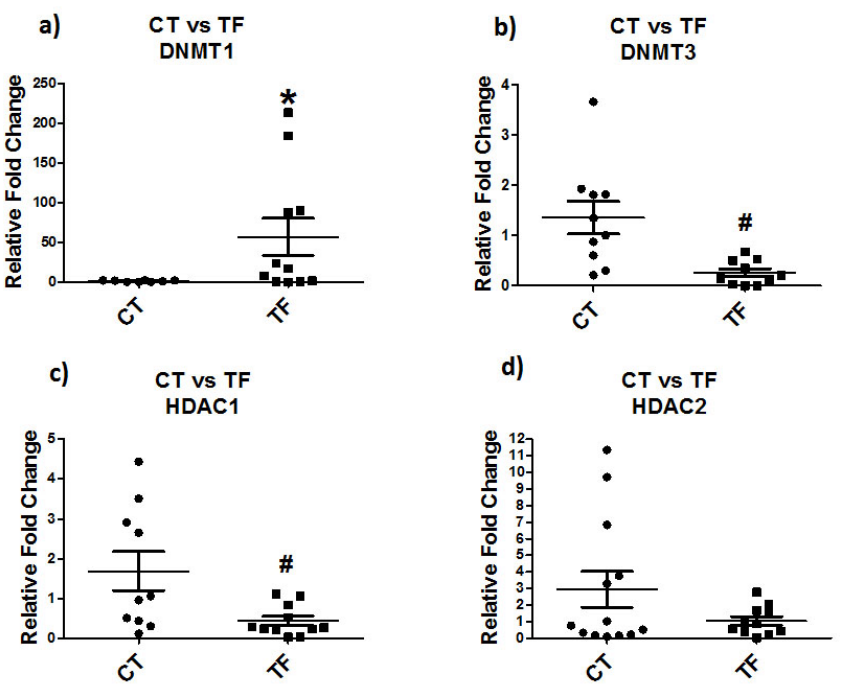
Figure 2: Methylation related genes dysregulated in trigger finger samples. ( a ) DNMT1, ( b ) DNMT3, ( c ) HDAC1, and ( d ) HDAC2 gene expression level dysregulated in trigger finger (TF) samples compare to Carpel tunnel syndrome (CT). *P<.05, # P<.001